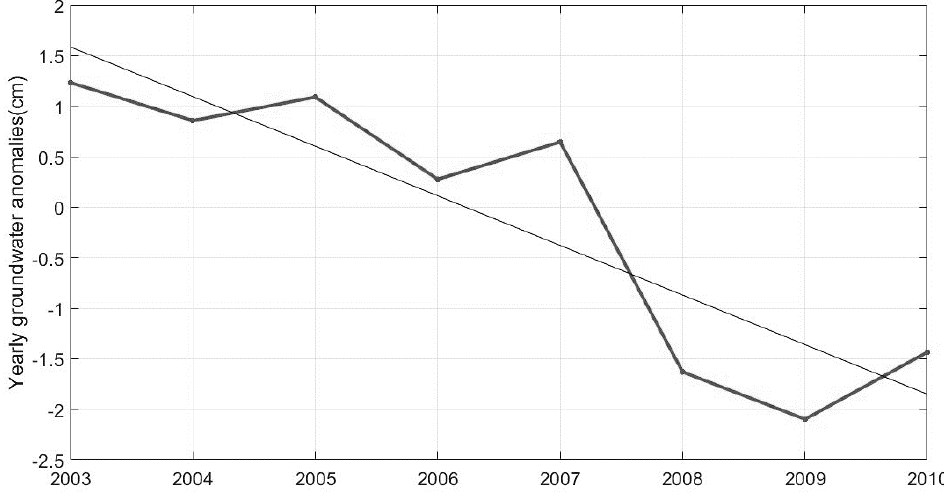
Figure 12. Yearly groundwater anomalies for the UAE, from 2003 to 2010.